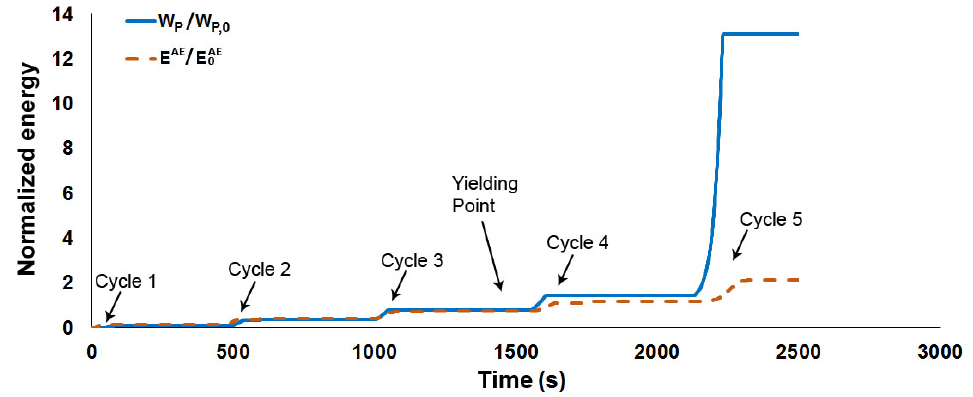
Figure 10 . Accumulated AE energy (dashed line) and accumulated hysteretic strain energy (solid line). RC beam with notch.